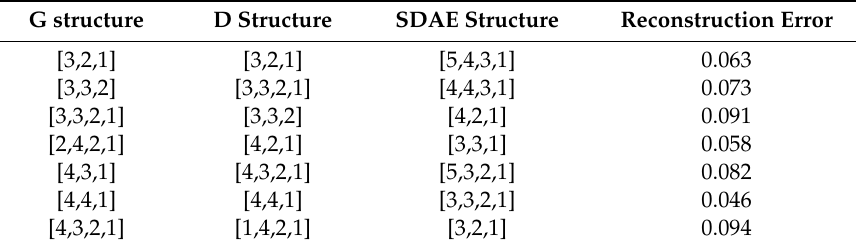
Table 2. Reconstruction error of the di ff erent network structures.